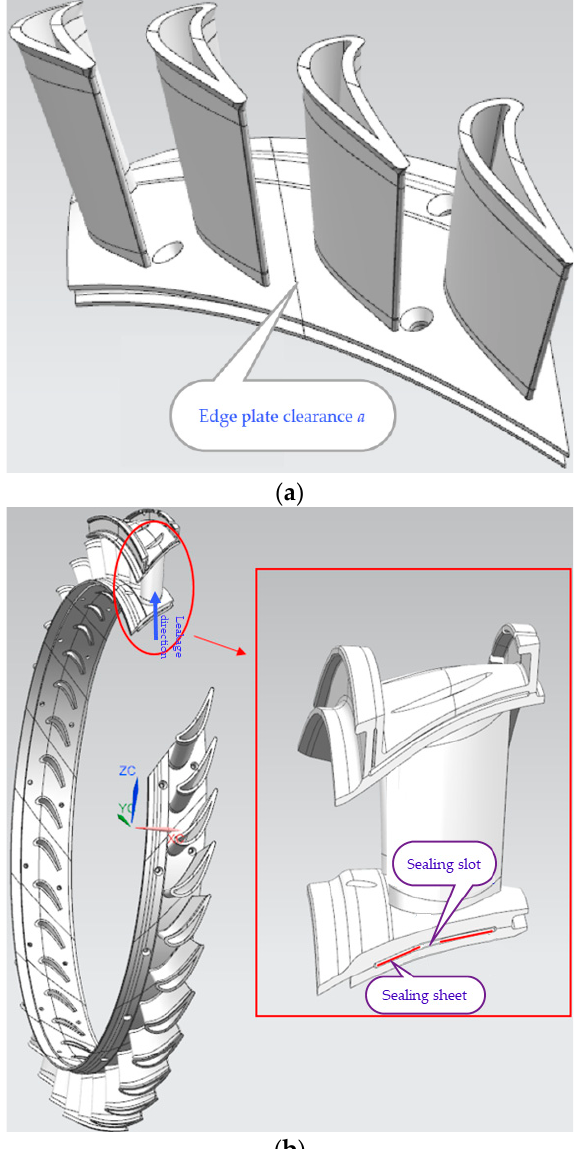
Figure 1. Schematic diagram of the installation position of the actual turbine blade edge plates. ( a ) The installation position of the sealing sheet. ( b ) Section of the installation position for the sealing sheet.